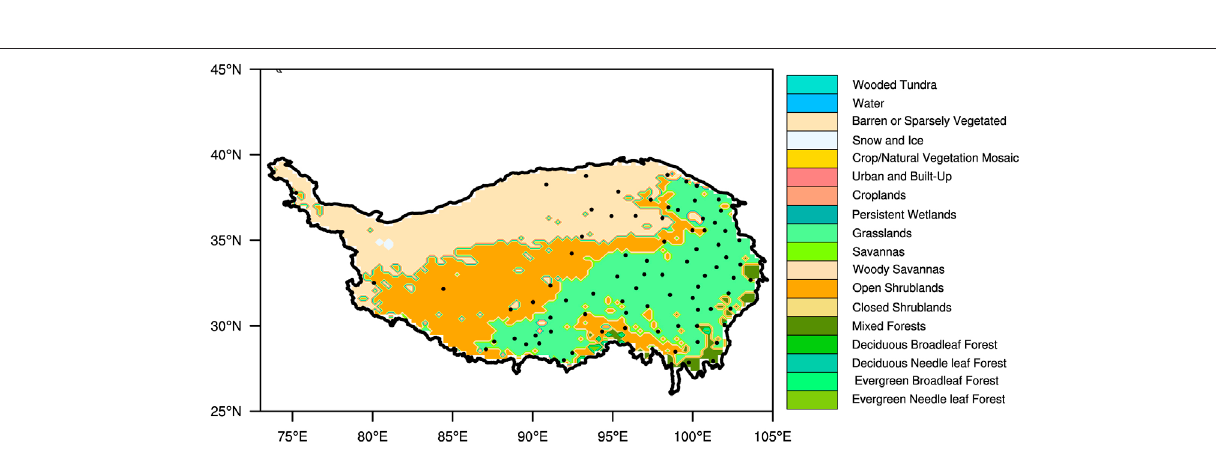
FIGURE 2 | The distribution of land use types in Qinghai-Tibet